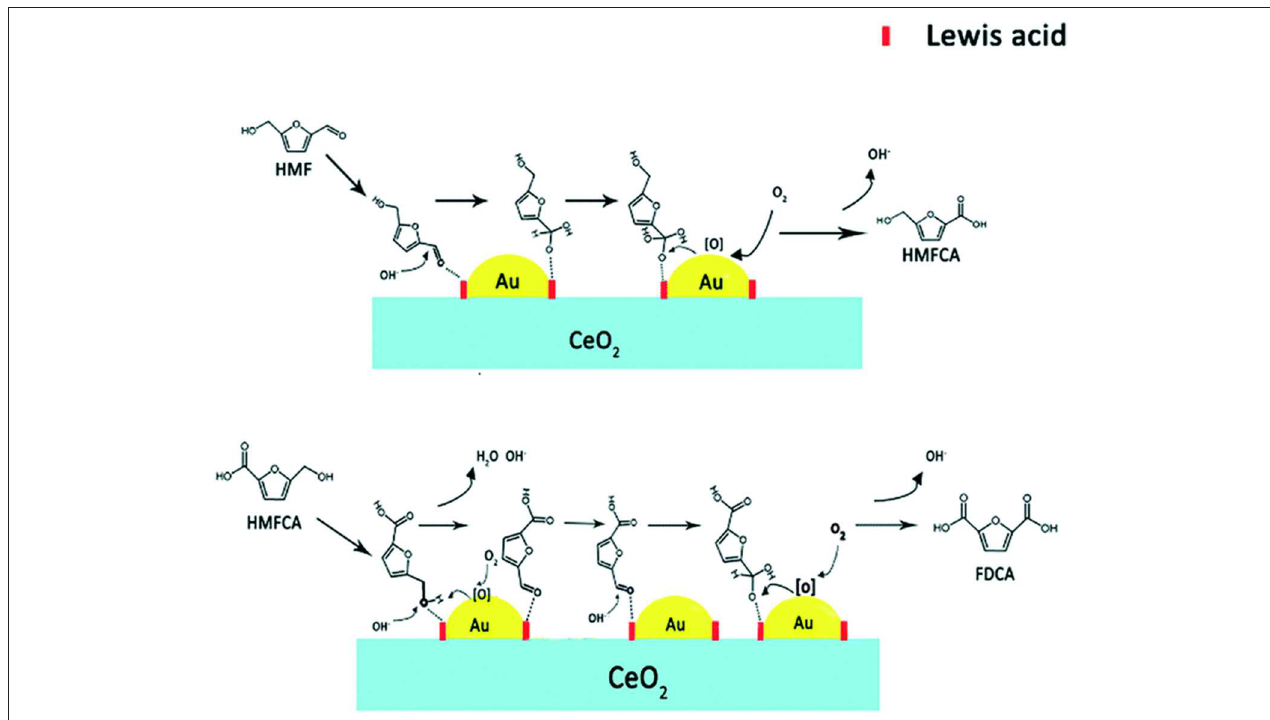
FIGURE 6 | Possible reaction mechanism for oxidation of HMF to FDCA with the Au catalyst (take Au@CeO 2 as an example). Used with permission of Royal Society of Chemistry, from Li Q. Q. et al. (2019) permission conveyed through Copyright Clearance Center,